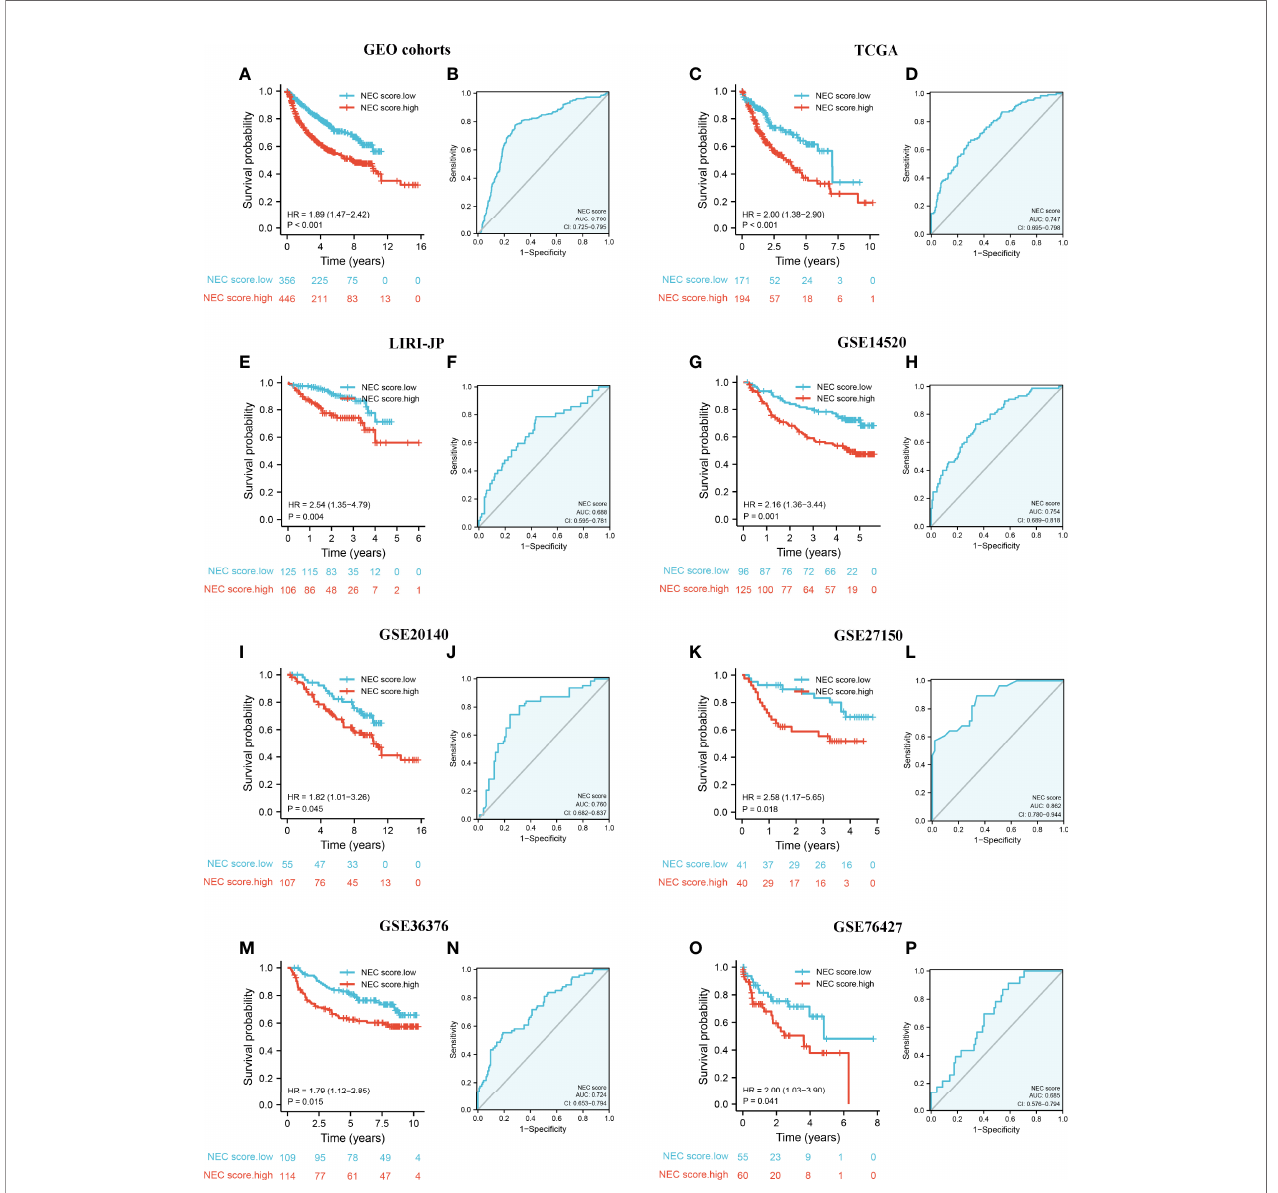
FIGURE 7 | External validation of NEC score model. (A) Kaplan-Meier curves for high and low NEC score patient groups in 5 GEO datasets (GSE14520/NCI, GSE36376, GSE76427, GSE20140, and GSE27150). (B) The predictive value of NEC score in 5 GEO dataset. (C) Kaplan-Meier curves for high and low NEC score patient groups in TCGA-LIHC. (D) The predictive value of NEC score in TCGA-LIHC. (E) Kaplan-Meier curves for high and low NEC score patient groups in LIRI-JP. (F) The predictive value of NEC score in LIRI-JP. (G) Kaplan-Meier curves for high and low NEC score patient groups in GSE14520/NCI. (H) The predictive value of NEC score in GSE14520/NCI. (I) Kaplan-Meier curves for high and low NEC score patient groups in GSE20140. (J) The predictive value of NEC score in GSE20140. (K) Kaplan-Meier curves for high and low NEC score patient groups in GSE27150. (L) The predictive value of NEC score in GSE27150. (M) Kaplan-Meier curves for high and low NEC score patient groups in GSE36376. (N) The predictive value of NEC score in GSE36376. (O) Kaplan-Meier curves for high and low NEC score patient groups in GSE76427. (P) The predictive value of NEC score in